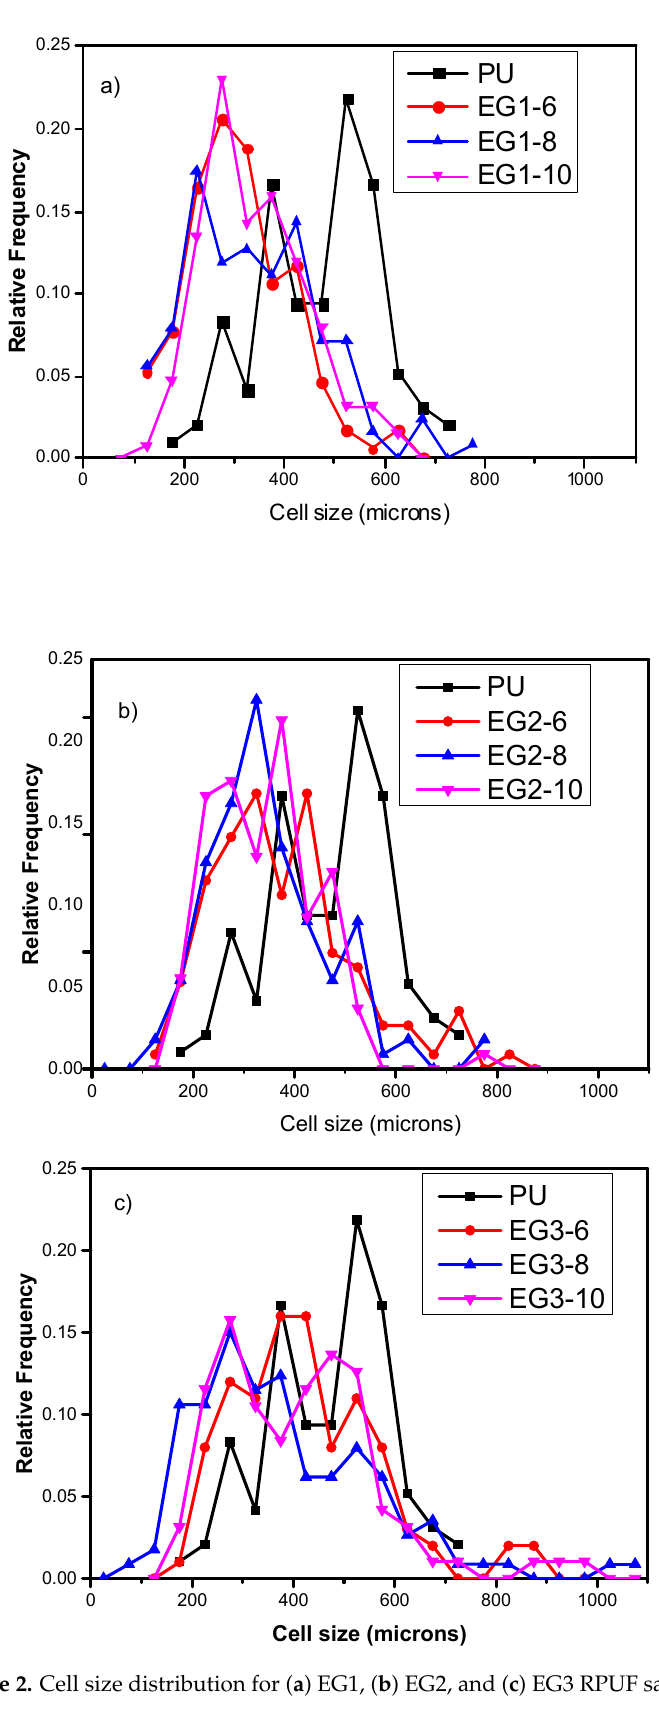
Figure 3. SEM micrograph of EG3-10 sample in the RPUF matrix. 3.2. Thermogravimetric Analysis TGA is one of the most relevant analysis for evaluating thermal properties of RPUFs. Thermogravimetric analysis (TGA) and differential thermogravimetry (DTG) analysis of neat RPUF (PU) and EG-filled RPUF samples on N 2 atmosphere are illustrated in Figure 4 (samples containing 10 wt % of EG) and S1, the data is collected in Table 3. The corresponding thermal parameters were: the initial decomposition temperature (T 5 wt % , namely the temperature at 5% weight loss), the temperature at maximum weight loss rate (T max , denoted as the peak value from the DTG curves), and the remaining residue at the end of the test. Both unfilled and EG-filled RPUFs showed a similar degradation curve for each sample. The degradation process consisted of a 2-steps process [36,42]. The first step of degradation for the neat RPUF was between 150 and 250 °C with ca . 7% weight loss. This step may be associated to the evaporation of small molecules of unreacted isocyanate monomers [43]. The second step of degradation occurred between 250 and 620 °C, and it was mainly due to the formation of the original PU components (isocyanates and polyols), due to the break of urethane bonds in hard segments [37,43]. Isocyanate formed remains, but polyol segments also decomposed into aliphatic ether alcohol, olefins, and CO 2 . As the temperature increased, more complex products were formed, such as amino compounds and CO 2 from former isocyanate were removed at ca . 350 °C. At higher temperatures ( ca. 500 °C), other products derived from isocyanate groups (such as amines